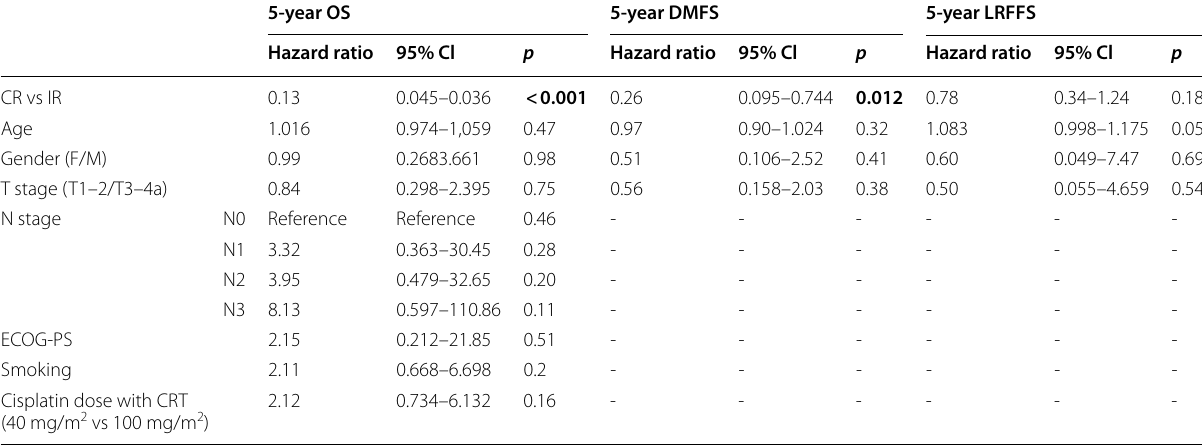
Table 2 Multivariate analyses of prognostic factors for nasopharyngeal